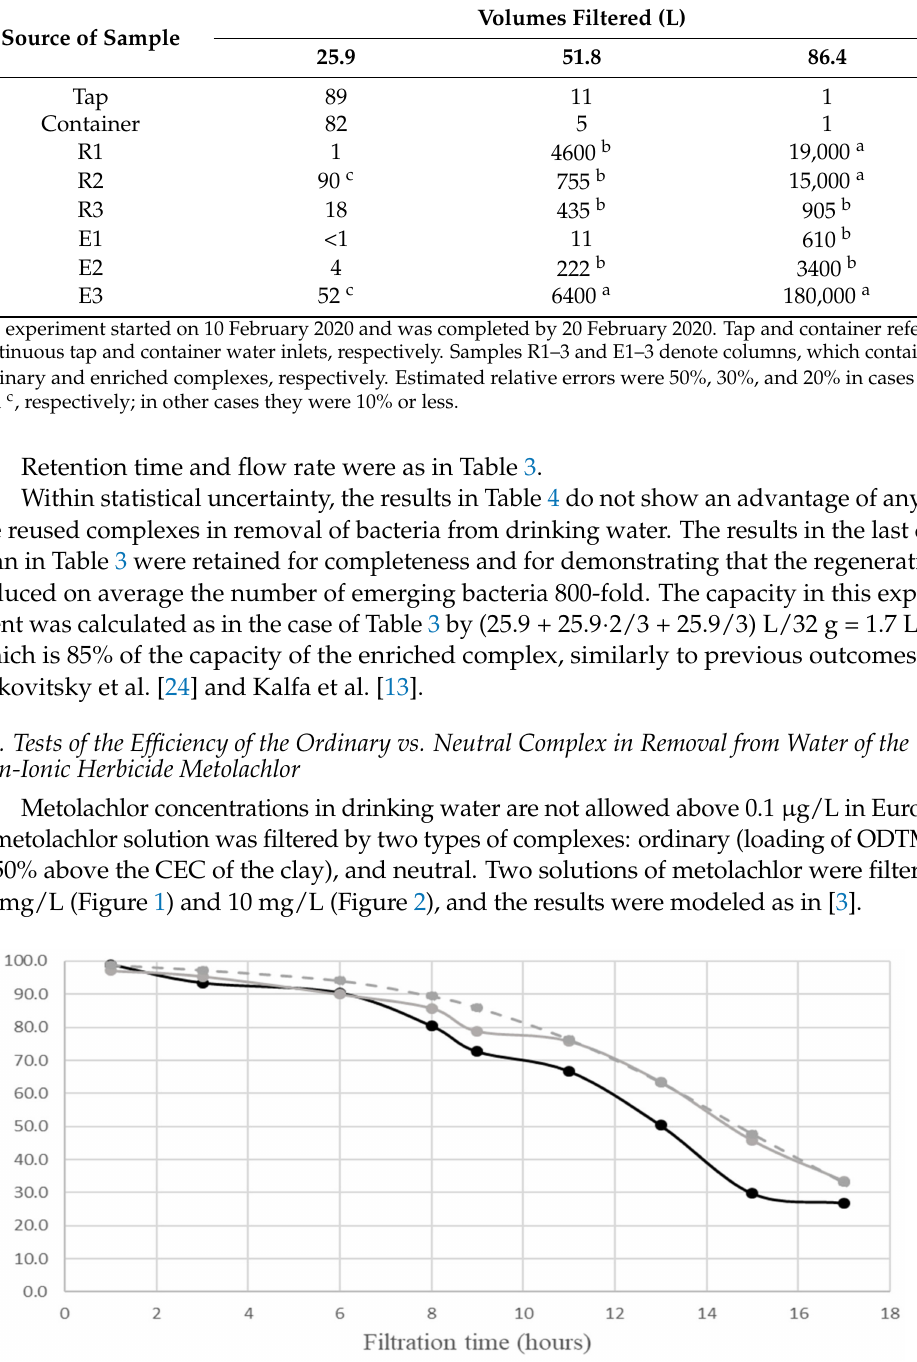
Figure 1. Percent adsorbed during filtration of metolachlor (50